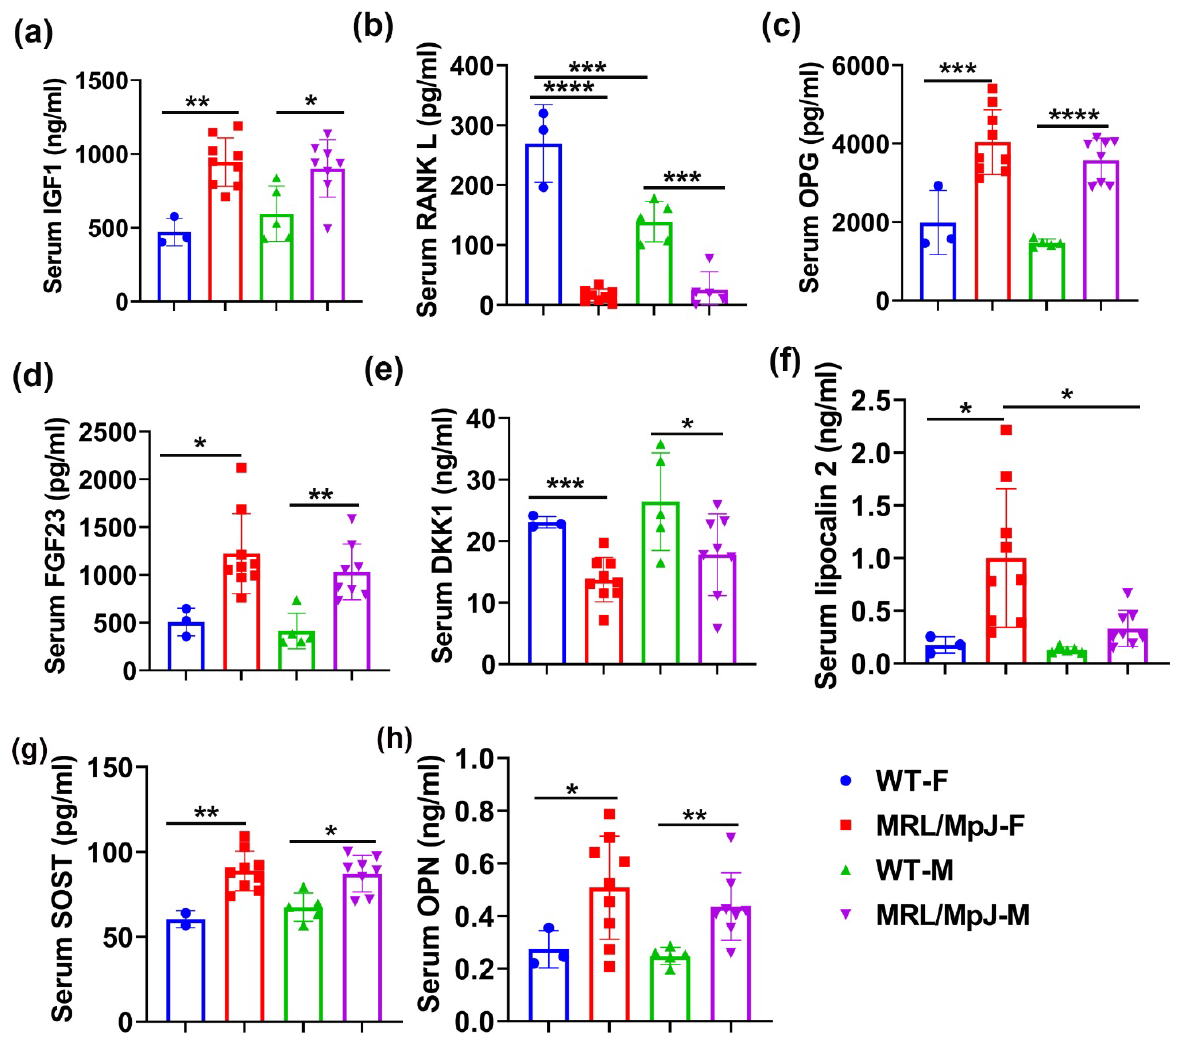
Figure 4. Serum bone-related marker levels of MRL/MpJ and WT mice at 14 M. ( a ) Serum IGF1 level. The IGF1 level was significantly higher in MRL/MpJ-F and MRL/MpJ-M mice than in WT-F and WT-M mice, respectively. ( b ) Serum RANKL level. The RANKL level in the serum was significantly higher in the WT-F mice than in the WT-M mice. RANKL was significantly lower in MRL/MpJ-F and MRL/MpJ-M mice than in the WT-F and WT-M mice, respectively. ( c ) Serum OPG level. OPG was significantly higher in the serum of MRL/MpJ-F mice than in their WT counterparts. ( d ) Serum FGF23 level. The FGF23 level was significantly increased in the serum of MRL/MpJ-F and MRL/MpJ-M mice compared to WT-F mice and WT-M mice, respectively. ( e ) Serum DKK1 level. The DKK1 level was significantly lower in MRL/MpJ-F and MRL/MpJ-M mice serum compared to that of the WT-F and WT-M mice serum, respectively. ( f ) Serum lipocalin 2 level. Lipocalin 2 was significantly higher in MRL/MpJ-F mice than the WT-F mice. Serum lipocalin 2 was also significantly higher in MRL/MpJ-F mice than in the MRL/MpJ-M mice. ( g ) Serum SOST level. The SOST level was signifi- cantly higher in MRL/MpJ-F and MRL/MpJ mice than in the WT-F and WT-M mice, respectively. ( h ) Serum OPN level. Serum OPN levels in MRL/MpJ-F and MRL/MpJ mice were significantly higher than in the WT-F and WT-M mice, respectively. All ANOVA: p < 0.0001. * p < 0.05, ** p < 0.01, *** p < 0.001, **** p < 0.0001. 2.5. MRL/MpJ Mice Demonstrated Less Severe Bone Loss after Long-Term Ovariectomy In vivo micro-CT scanning was performed for the lumbar spine and proximal tibia trabecular bone after ovariectomy surgery. For the spine L5 trabecular bone, micro-CT 3D images demonstrated a higher trabecular bone mass in MRL/MpJ-Sham and MRL/MpJ-